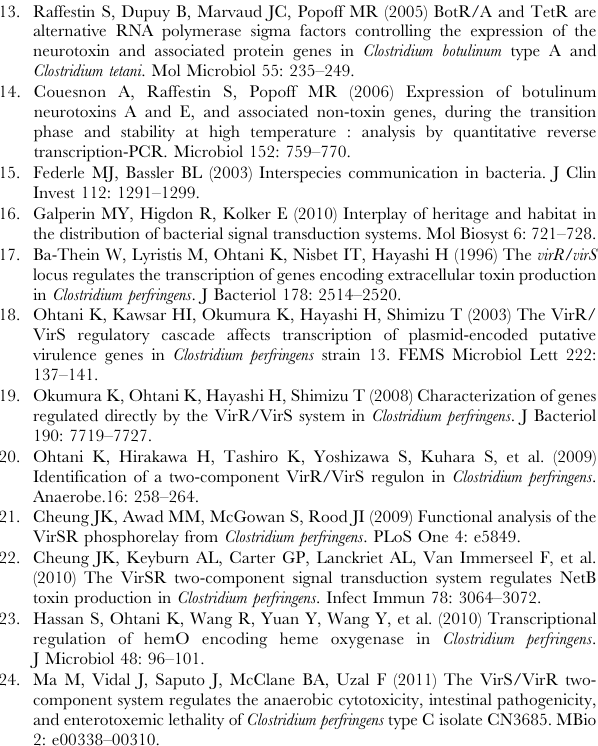
Table S1 Optimization of quantitative PCR amplification.